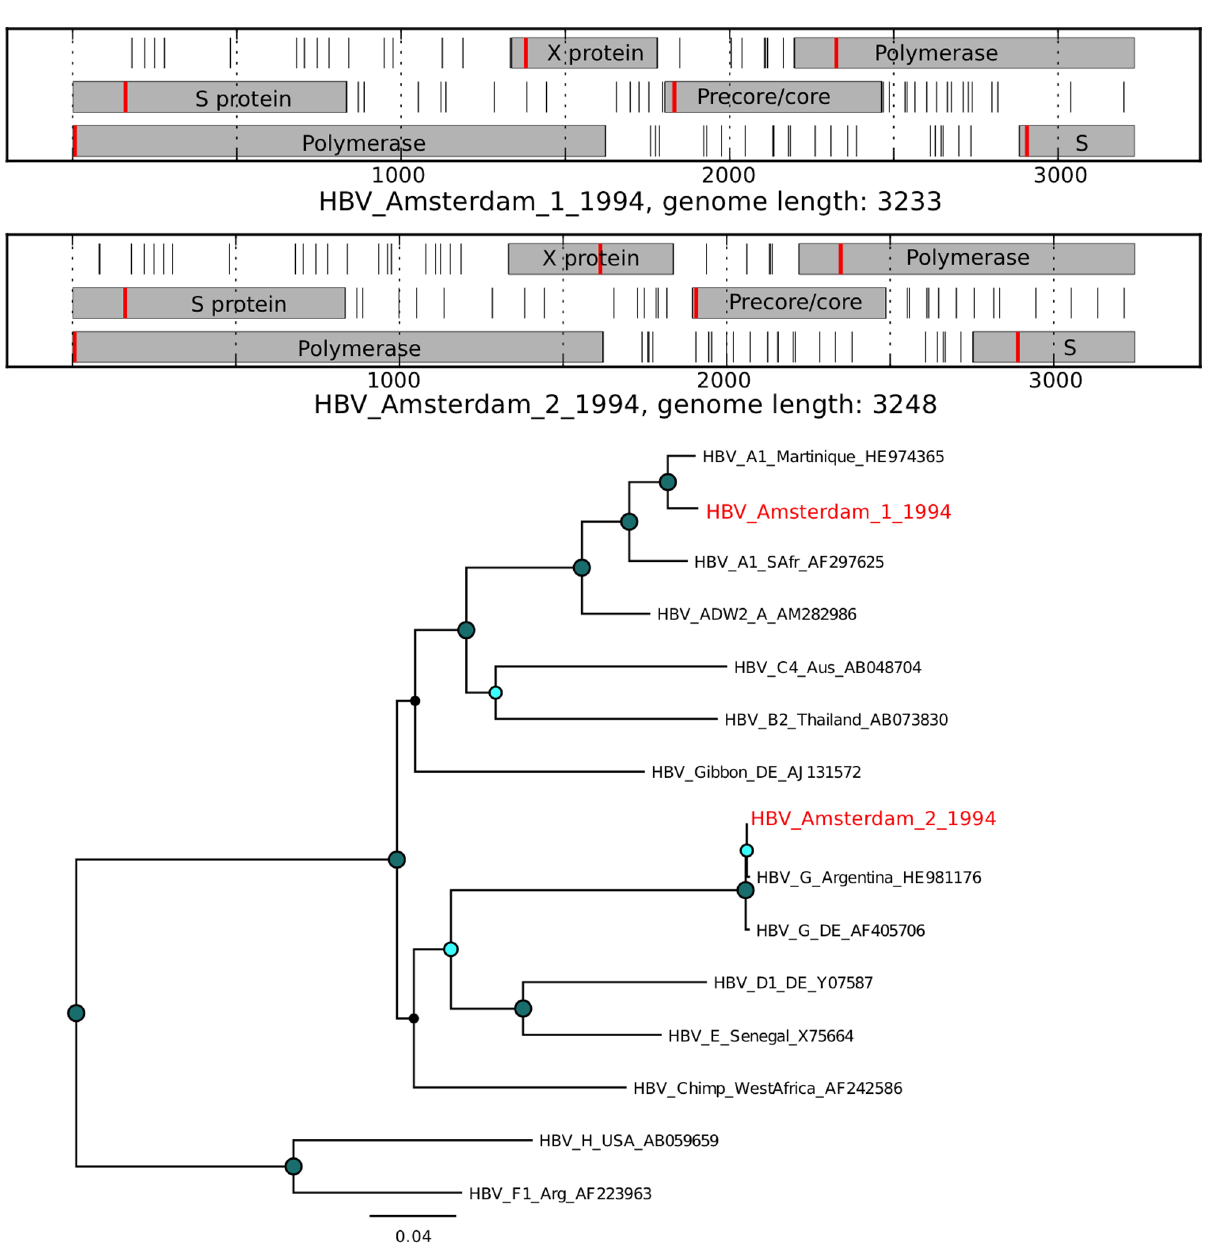
Figure 9. Open reading frame structure and phylogenetic analysis of the hepatitis B virus genomes identified in this study. Analysis and graphical presentation was performed as described in the legend to Figure 7. The HBV reference genome set was from reference